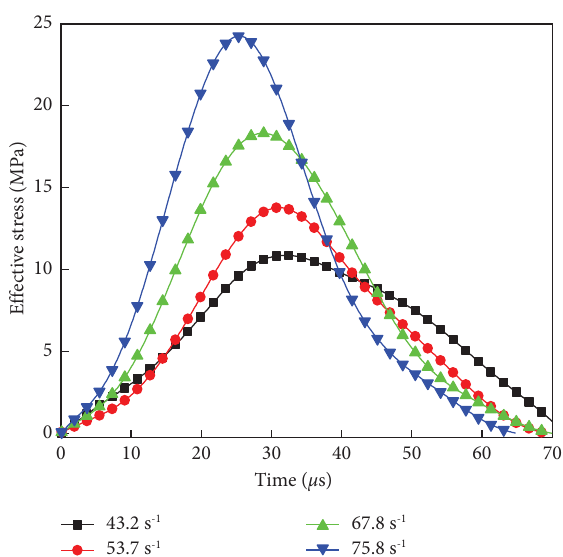
Figure 4: Efective stress-time history curve of the specimen under diferent strain rates when d is 3mm and W is 42%.